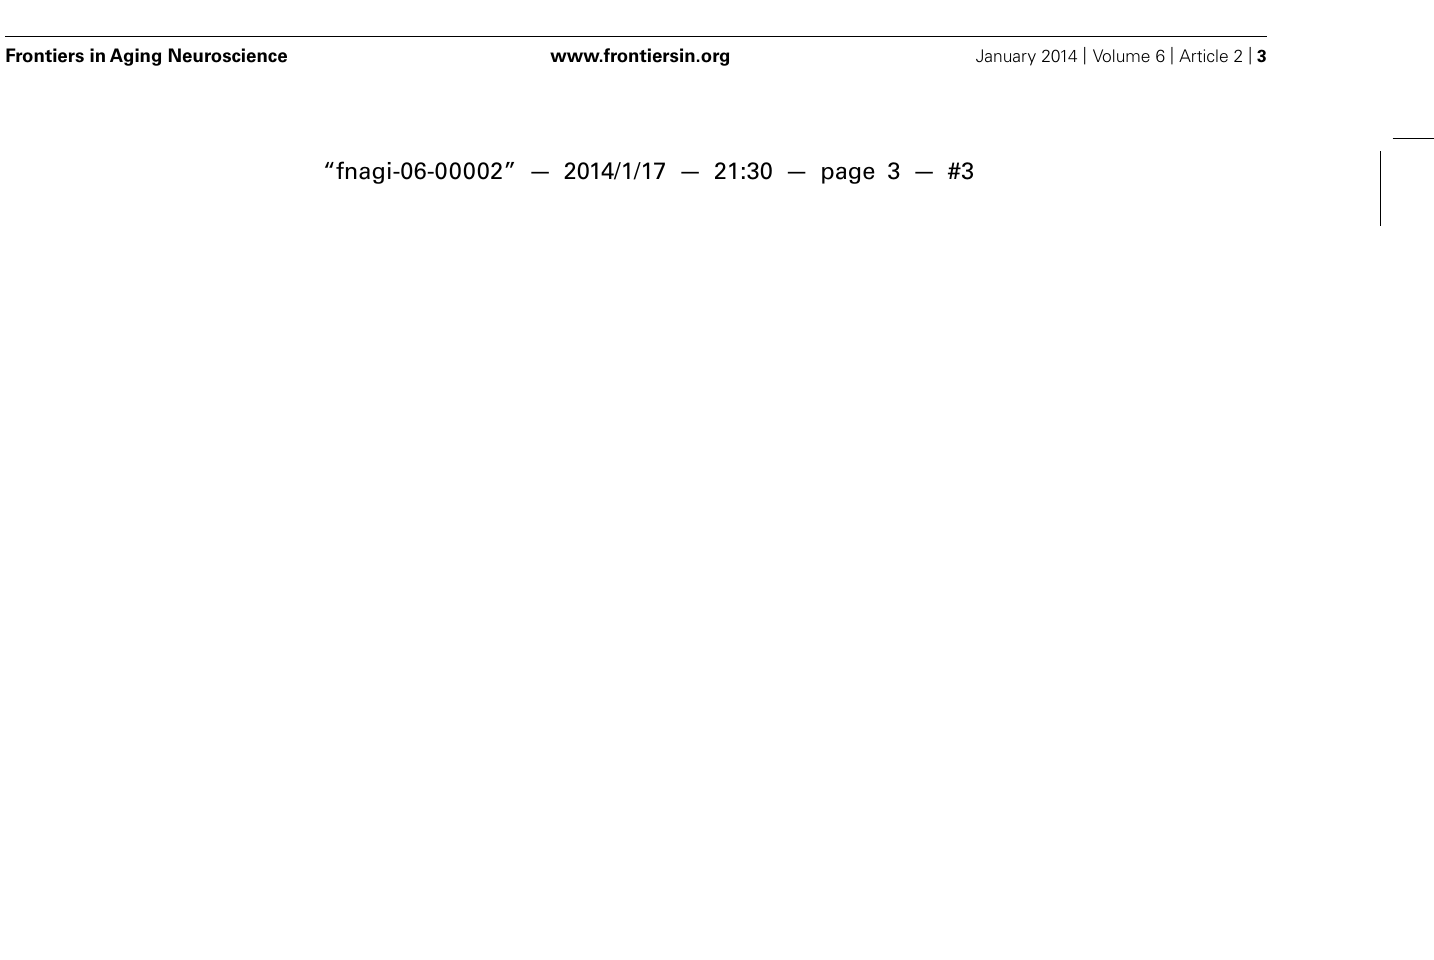
spatial reference memory (day 14), one day spatial episodic memory (day 14), and long-term spatial reference memory (days 5–11). A retention probe trial was conducted 24 h after the final training trial in each